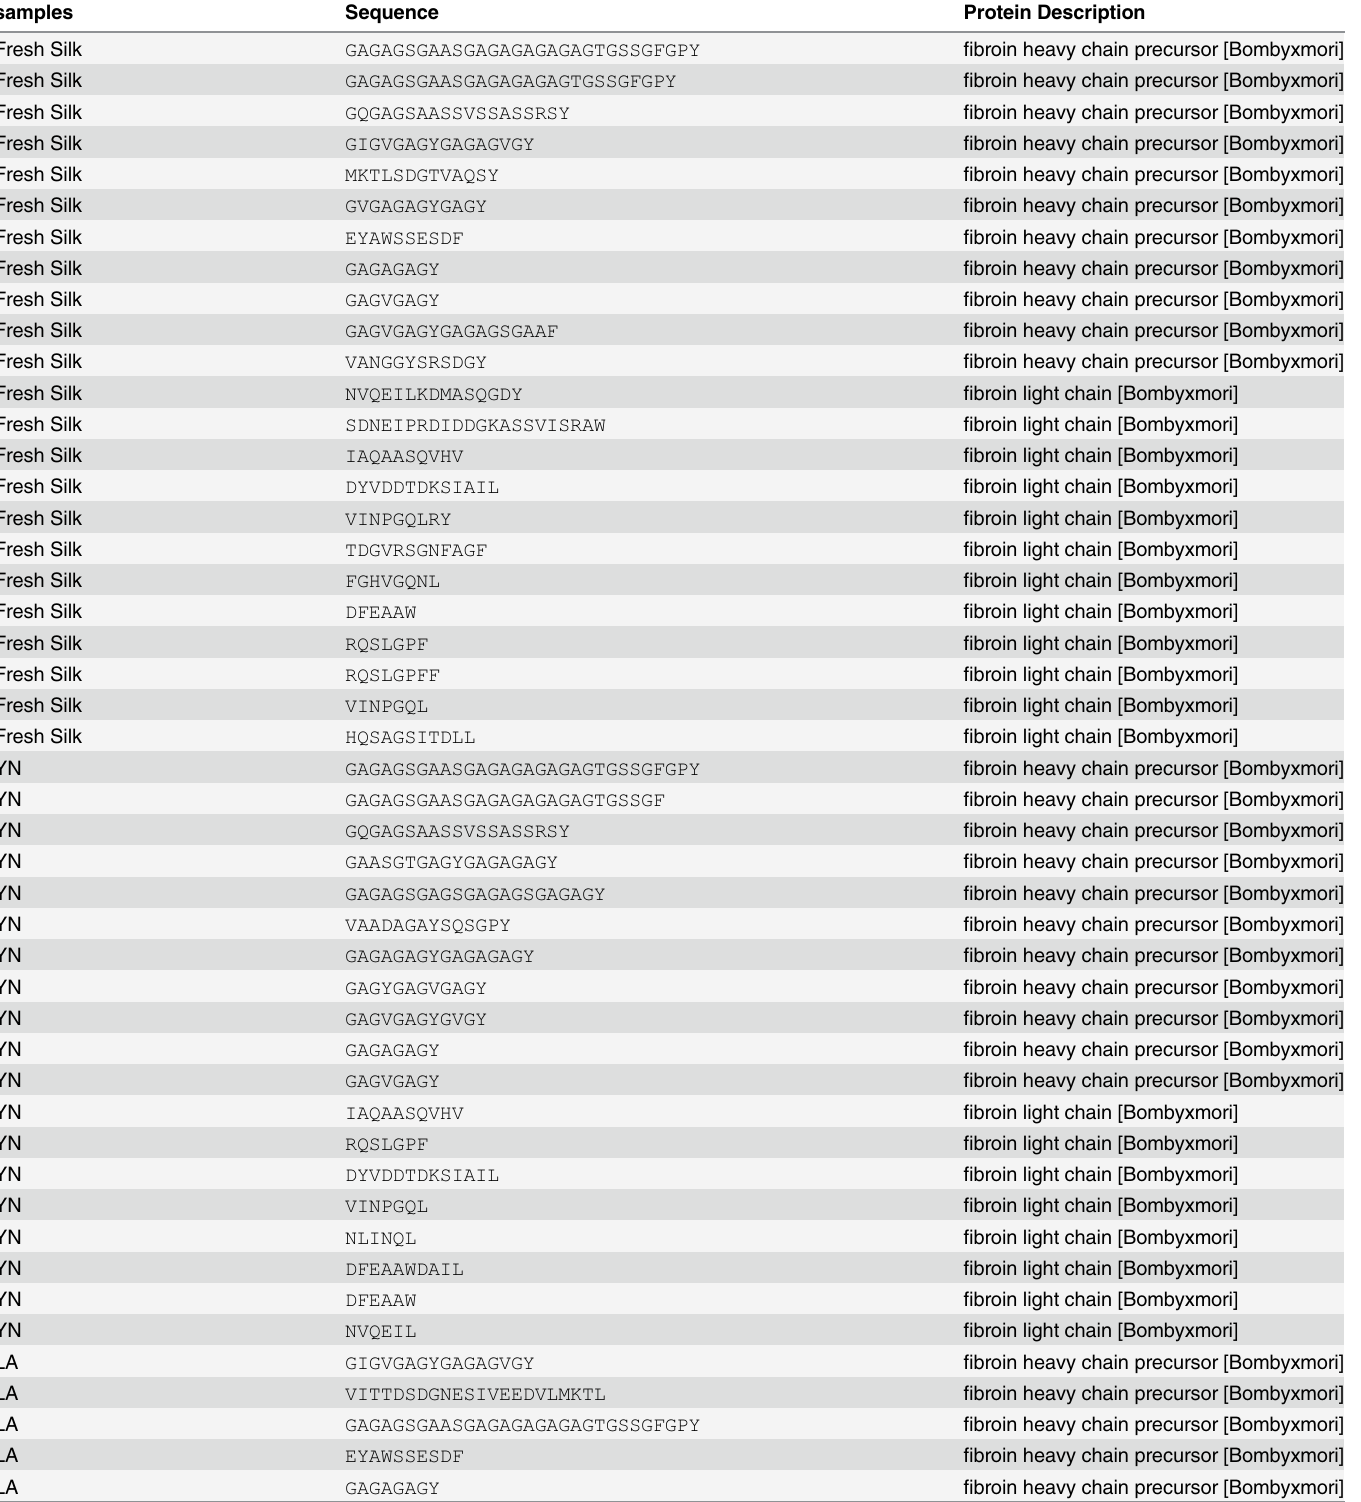
Table 1. The detected peptide sequences of silk protein of fresh silk.